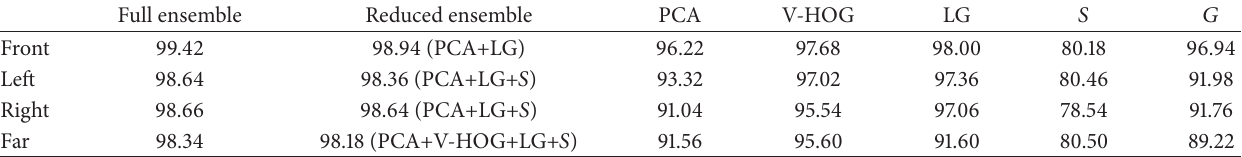
Table 15: Performance comparison between the proposed fusion scheme and the individual classifiers. Full